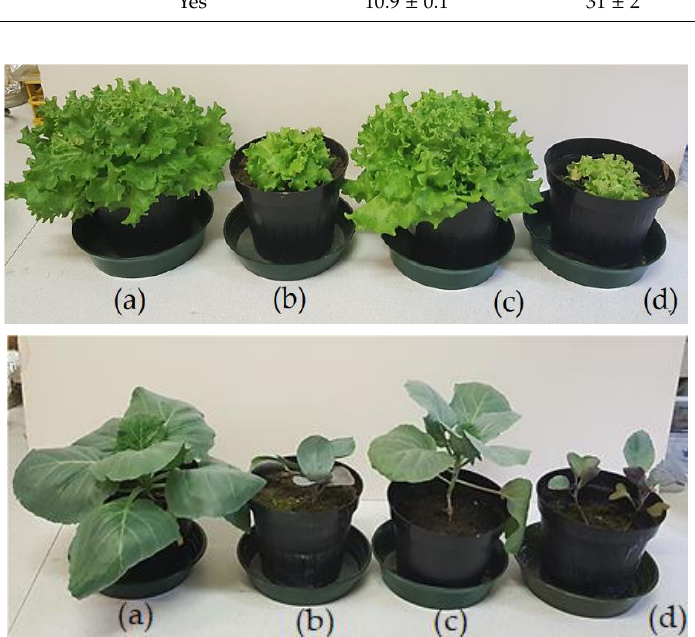
Figure 1. Plants of Lactuca sativa (top) and Brassica oleracea (bottom) grown under different conditions: ( a ) = NOB soil with AM, ( b ) = NOB soil without AM, ( c ) = CA soil with AM, ( d ) CA soil without AM.